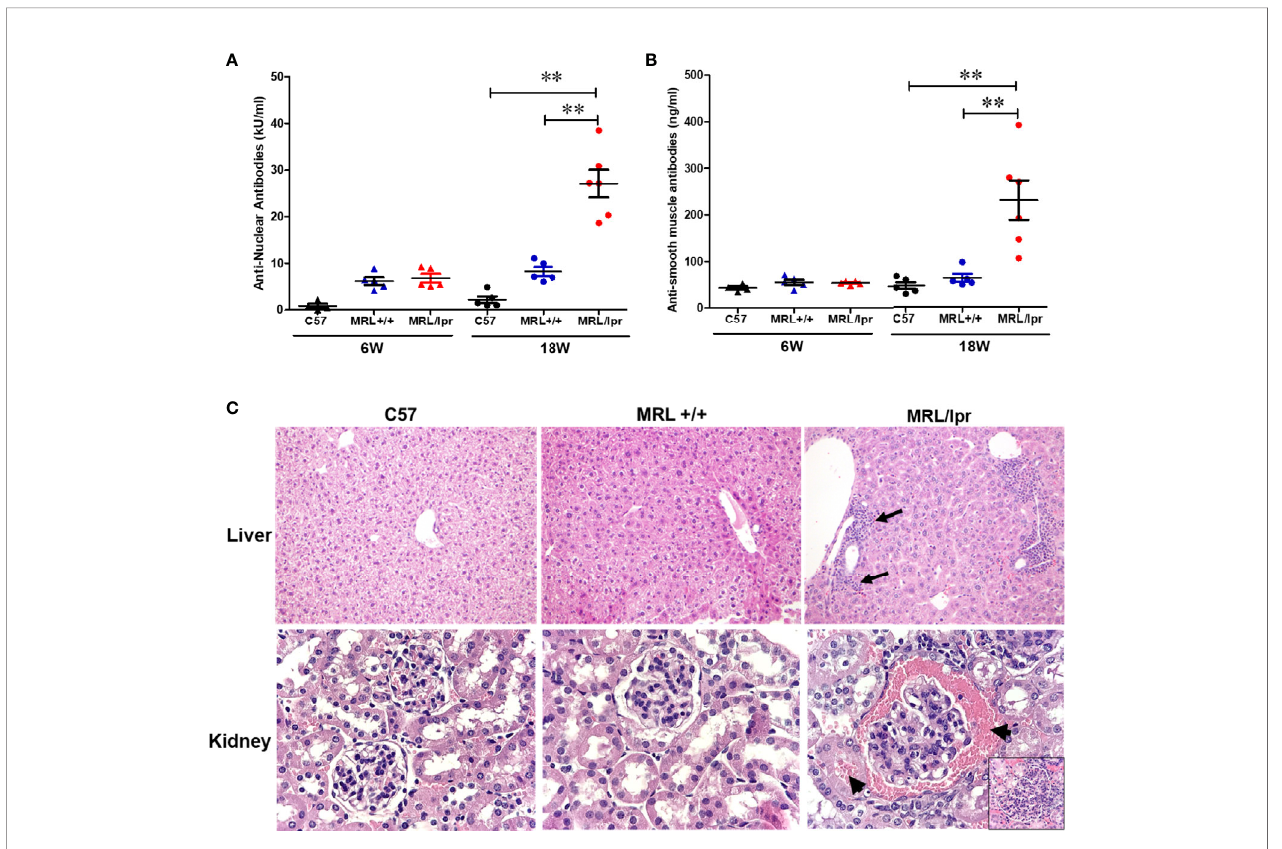
FIGURE 1 | Spontaneous development of SLE- and AIH-like diseases in MRL/lpr mice. Serum ANA levels (A) and serum ASMA levels (B) in C57BL/6 (C57), MRL+/+ and MRL/lpr mice. Histopathology of liver (C) shows marked various peri-portal in fi ltrates (arrows) in MRL/lpr mice. Renal histopathology (lower panel) shows glomerulus with hypercellularity and red blood cells in Bowman ’ s spod and adjacent tubule (arrows) in MRL/lpr mice, indicative of acute glomerulonephritis (H&E). n = 5, ** p <